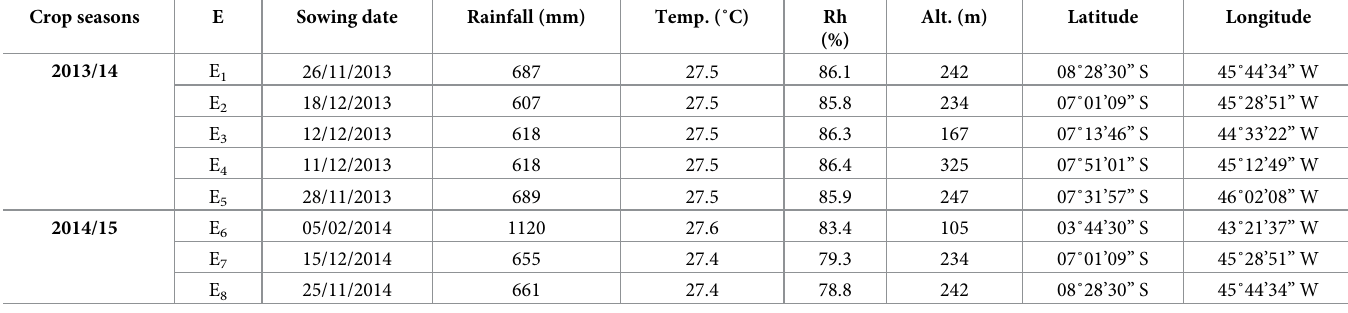
E = Environment; Alt. = Altitude; Temp. = Temperature average; Rh = Relative humidity; E 1 = Tasso Fragoso (MA), E 2 = S ã o Raimundo das Mangabeiras (MA), E 3 = Uruc¸uı´(PI), E 4 = Baixa Grande do Ribeiro (PI), E 5 = Balsas (MA), E 6 = Chapadinha (MA), E 7 = S ã o Raimundo das Mangabeiras (MA), E 8 = Tasso Fragoso (MA). Source: